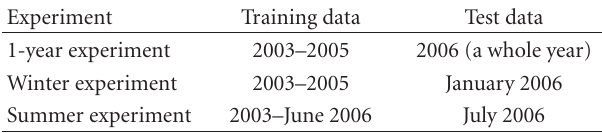
Table 3: The training data and test data in each